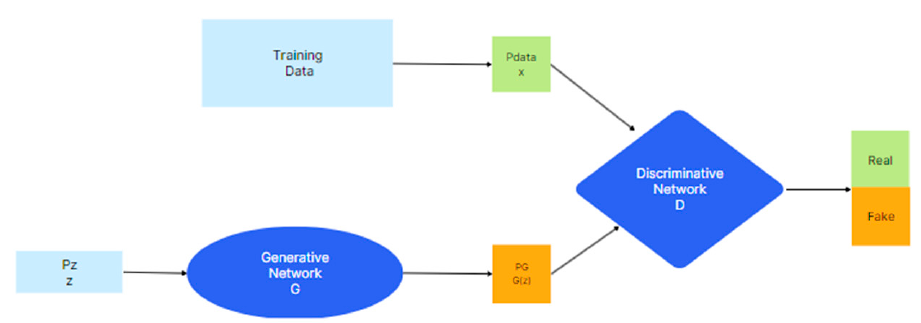
Figure 1. This figure presents the basic GAN structure. The two models learned during the GAN training process are the Generator (G) and the Discriminator (D). Here, “z” is random noise, and G(z) indicates how G attempts to learn the distribution PG from distribution Pz. Pdata denotes the real-world dataset.